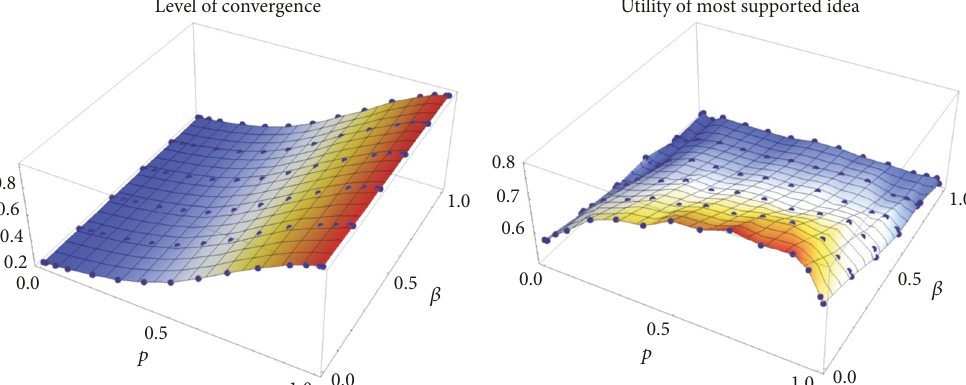
Figure 3: Effects of Balance between Selection-Oriented and Variation-Oriented Behaviors and Group-Level Bias on Decision Convergence and DecisionQuality .Note:Effectsofbalancebetweenselection-orientedandvariation-orientedbehaviors( 𝑝 )andgroup-levelbias( 𝛽 )onthelevel of convergence (left) and the true utility value of the most supported idea (right). Each dot represents an average result of 500 independent simulation